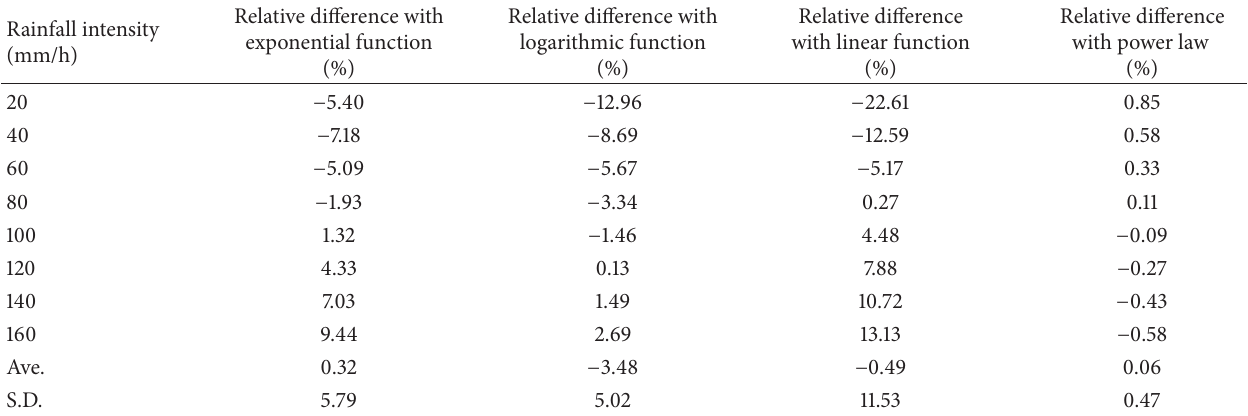
Table 2: Relative differences in kinetic energy between universal power law and average kinetic energies evaluated by empirical equations. Rainfall intensity (mm/h) 20 − 5.40